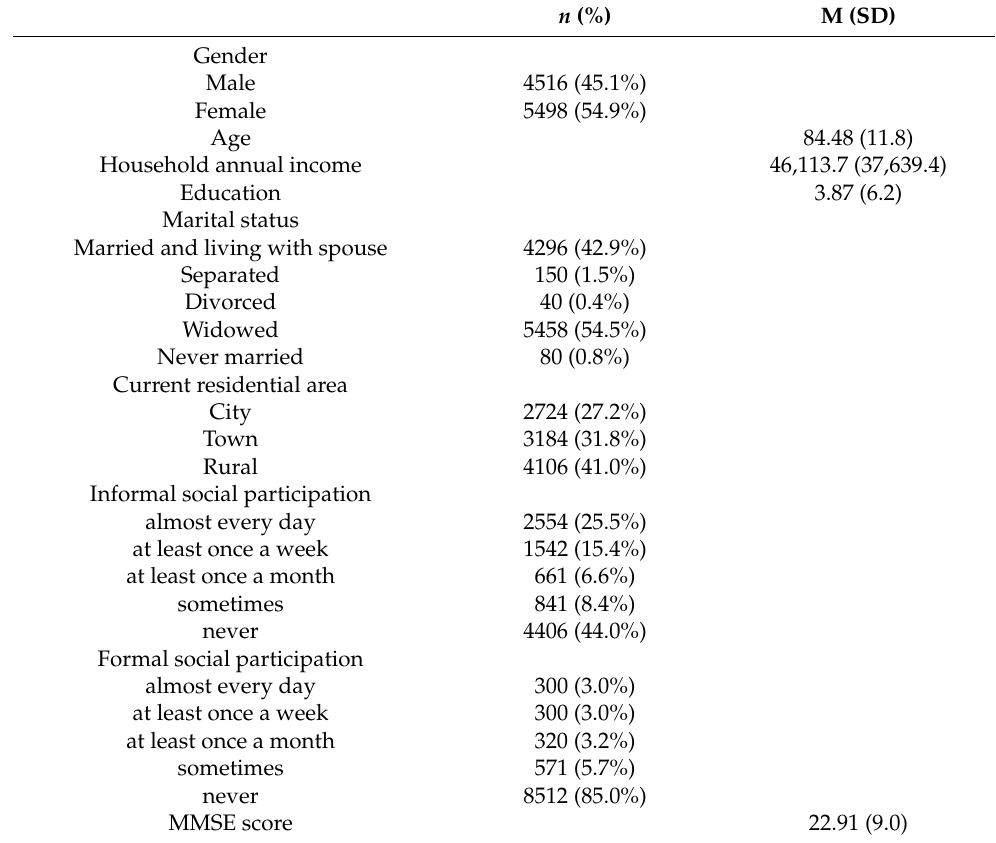
Table 1. Characteristics of the older adults ( n =